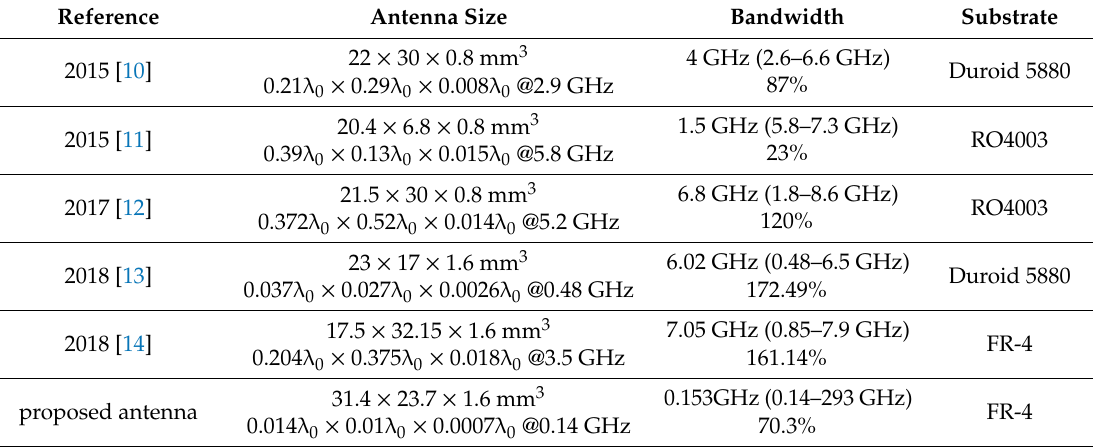
Table 5. Comparison table with CRLH